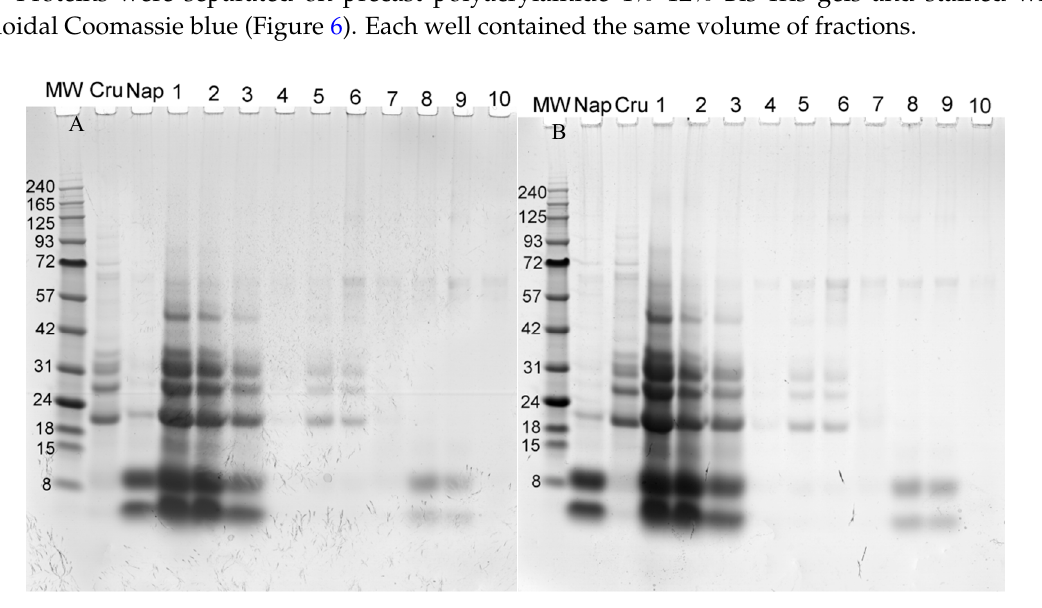
Figure 6. Electrophoresis pattern of fractions from conventional ( A ); or ultrasound-assisted ( B ) extraction under reducing conditions. MW molecular weight markers in kDa: (Nap) Napin standard, (Cru) Cruciferin standard, (1) extract; (2) filtered extract; (3) depigmented extract; (4) Superdex 75 peak 1 Aggregates; (5) and (6) Superdex 75 peak 2 Cruciferin; (7) Superdex 75 peak 3; (8) and (9) Superdex 75 peak 4 Napin; (10) Superdex 75 peak 5.